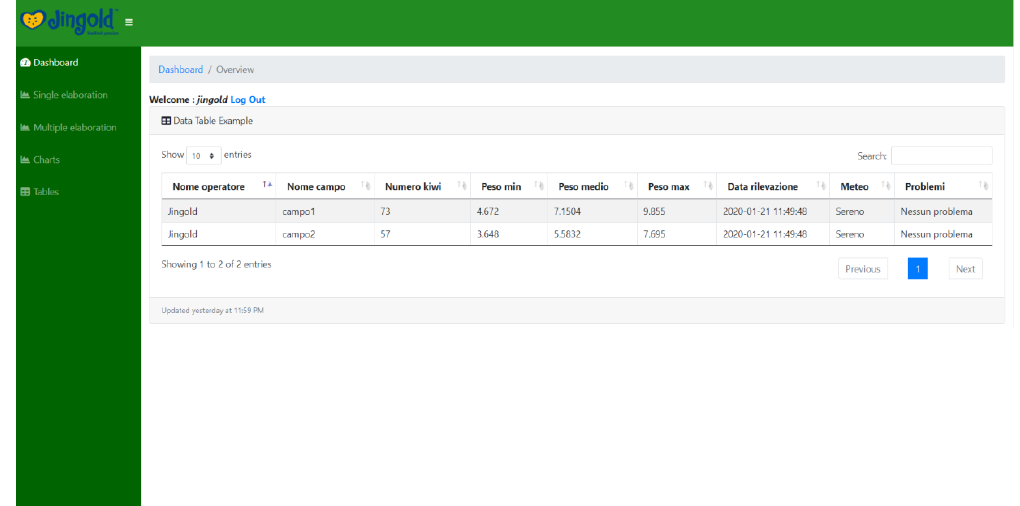
Figure 18. Login page of the web interface.